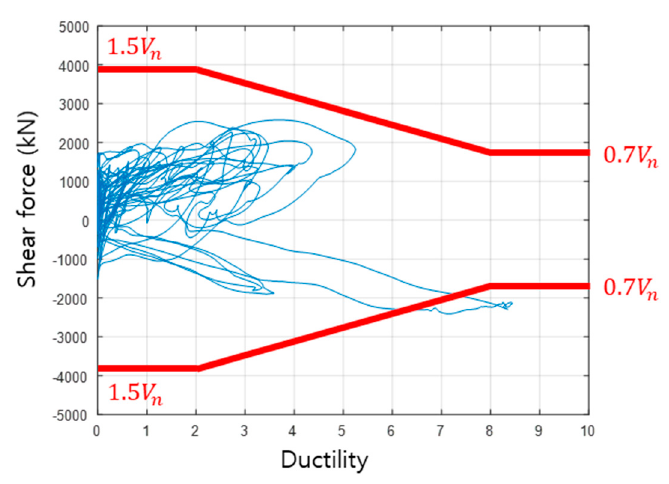
Figure 14. Example of shear failure (Model A, R3).